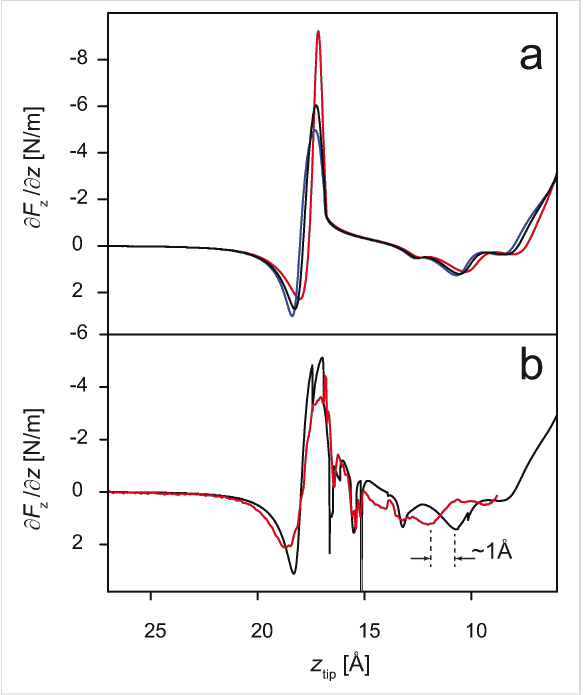
Figure 4: (a) Comparison between the ∂ F z / ∂ z ( z ) curves of PTCDA lifted from Au(111), obtained for different tip elastic constants. Simula- tions take oscillations of the qPlus sensor and the surface corrugation into account. Lateral forces are zeroed out (cf. text). Red corresponds to k tip = ∞ , blue to k tip = 9 N/m, black to k tip = 14 N/m. (b) Comparison between an individual experimental curve (red) taken from the series shown in Figure 1a and the simulation (black) obtained with oscilla- tions of the qPlus sensor, tip flexibility, surface corrugation, and non- zero lateral forces acting during lifting. Sharp spikes in the black curve indicate sliding of the lower end of PTCDA across the corrugated potential of the